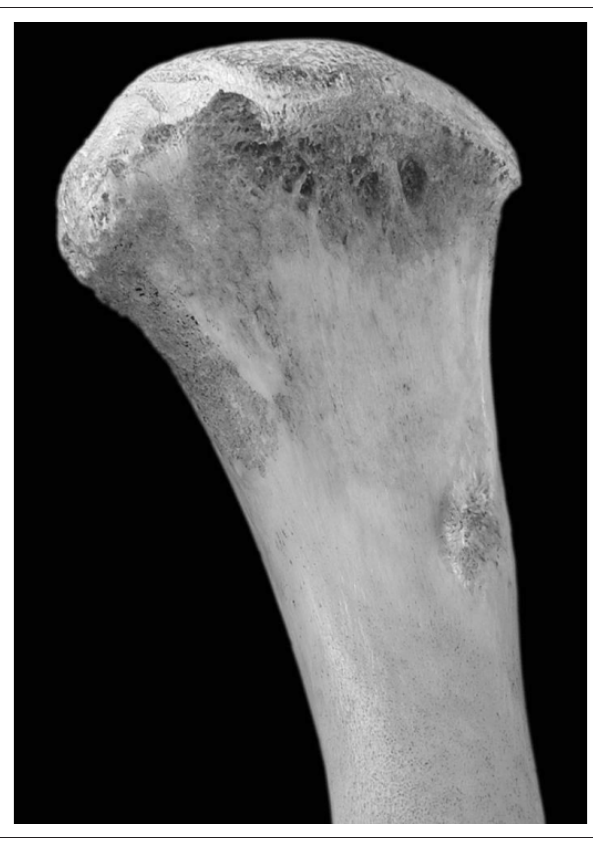
FIGURE 3: Humerus of a juvenile Nile crocodile, case 2: Almost complete loss of the caput